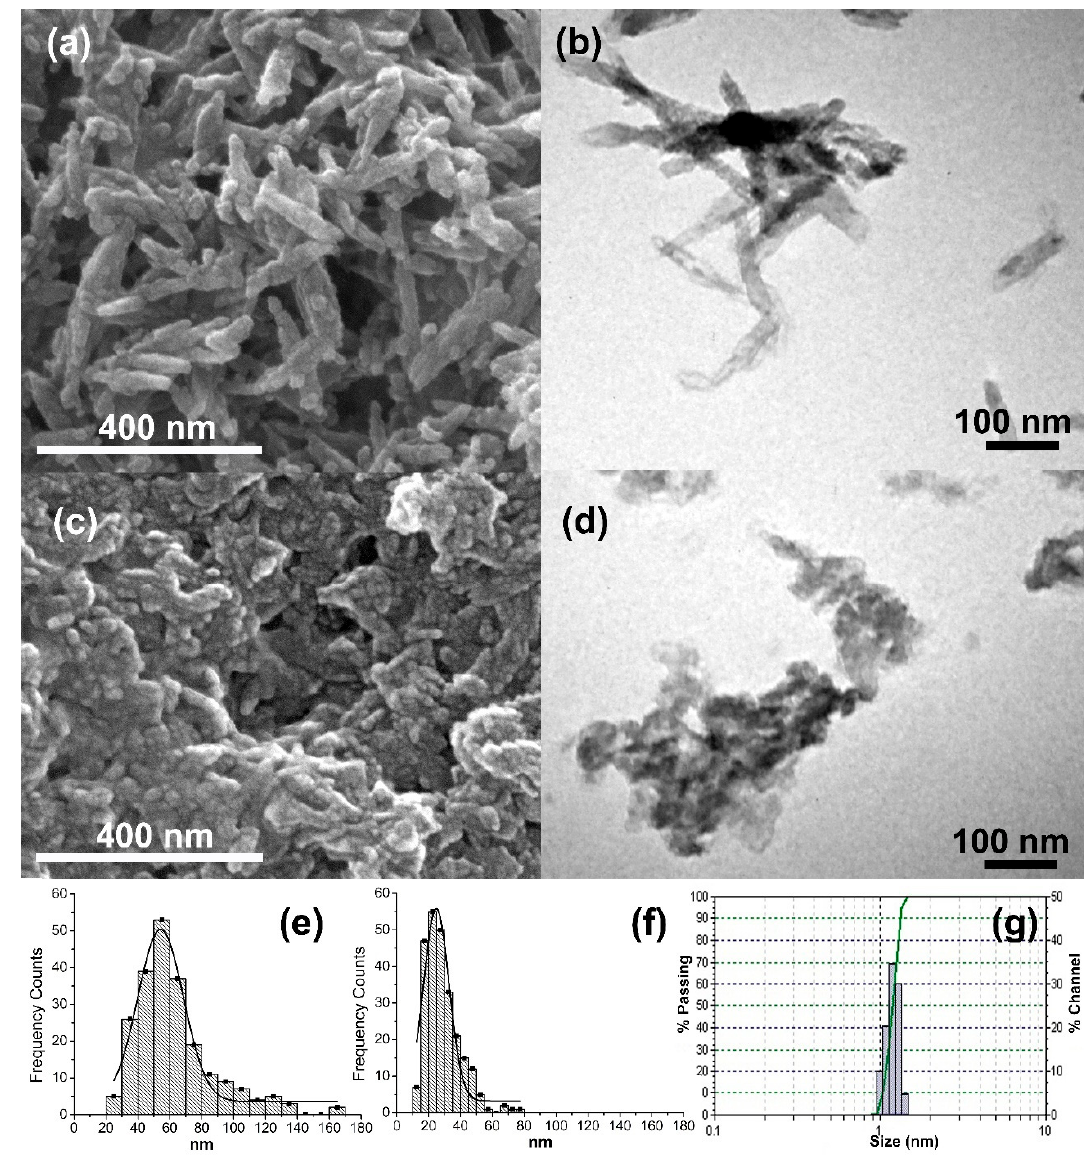
Figure 1. Morphological and dimensional characterization of HA ( a,b,e,g ) and CDHA ( c,d,f ) particles synthesized. ( a , c ) FESEM micrographs; ( b , d ) TEM micrographs and ( e , f ) size particle distributions calculated by FESEM image processing; ( g ) size particle distribution of nanoHA particles synthesized by Dynamic Light Scattering (DLS). Particle size illustrated in ( e , f ), and ( g ) correspond to the particles’ diameter.